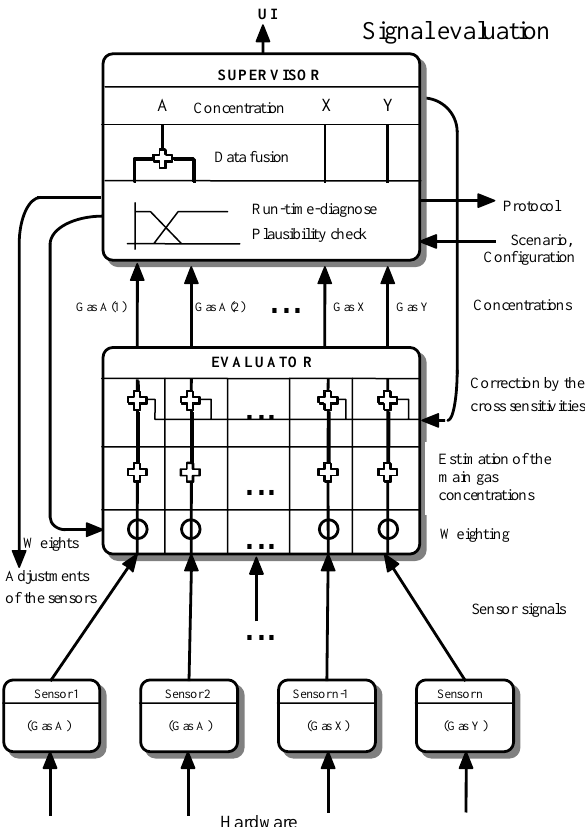
Figure 1. The IGM-software components evaluator and supervisor